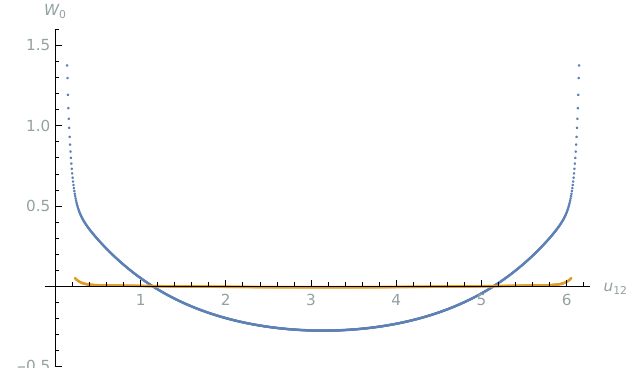
Figure 23 . The connected part of the out-of-time order four-point function. The yellow graph has a larger (cid:30) r and is closer to